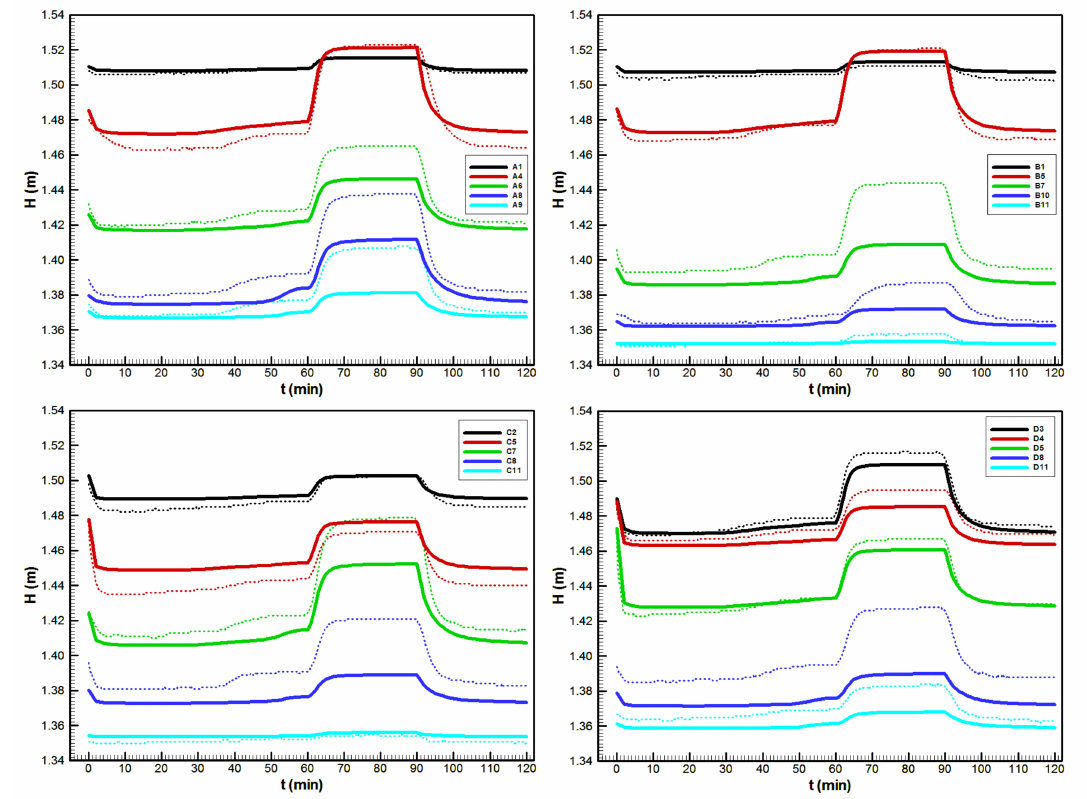
Figure 15. Hydraulic head: Experimental (dashed line) and numerical (solid line)